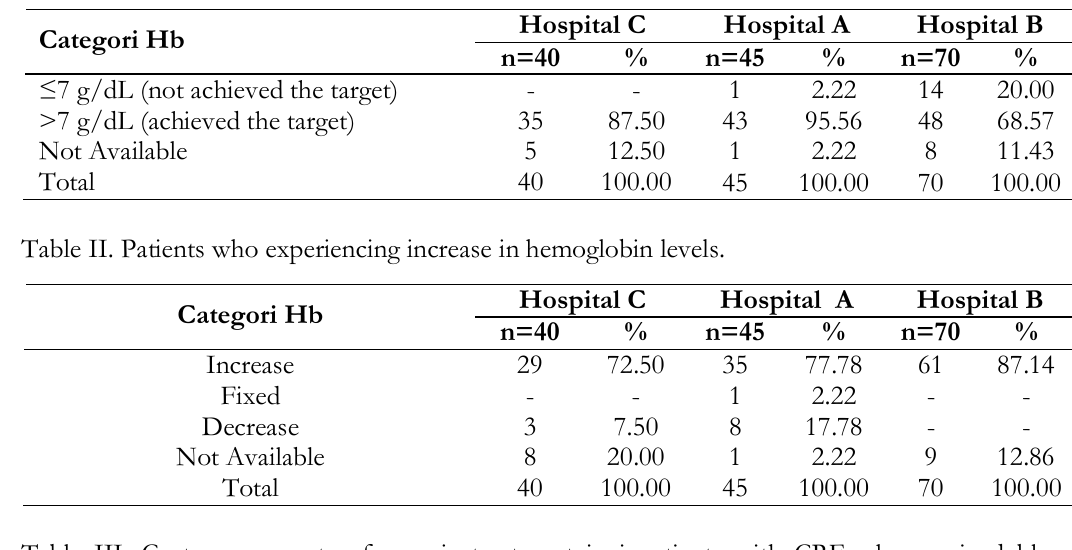
Table I. Patients who achieved targeted therapy.